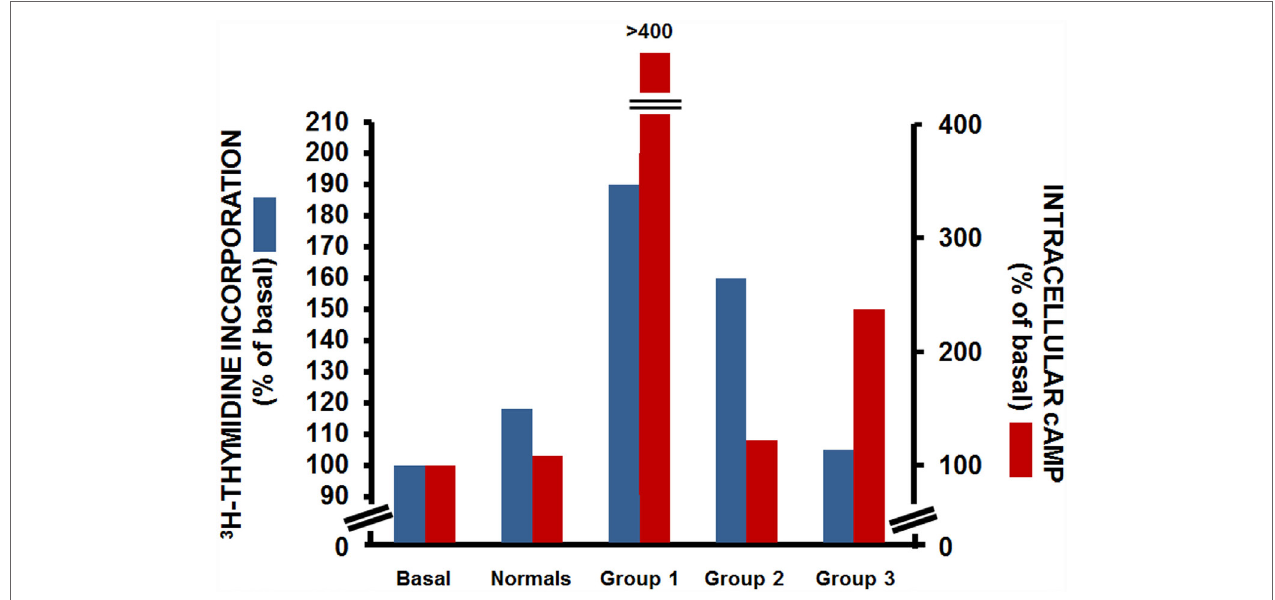
FiGURe 2 | effects of igG from patients with Graves’ disease on [ 3 H]-thyimidine incorporation (blue) and intracellular cAMP production (red) in FRTL-5 cells . Data from three representative patients with Graves’ disease for each group. Basal, cells with no treatment; normals, cells incubated with a pooled sample of IgG from 13 non-Graves’ individuals [Data are from Ref.